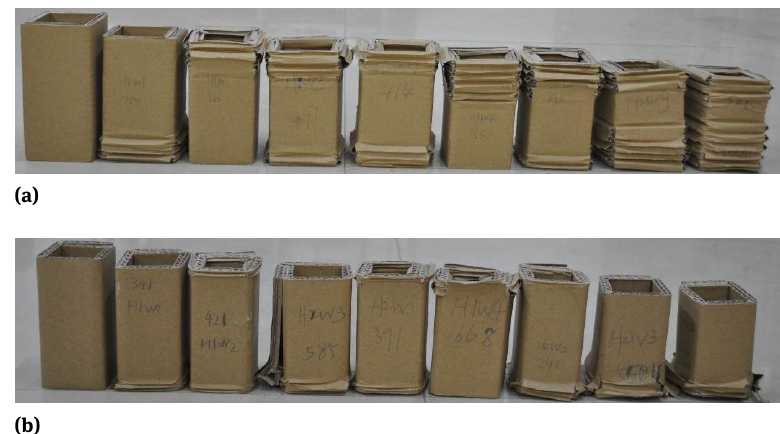
Figure 15: Influence of impact energy on deformation mode: (a) X- and (b) Y-direction square paper corrugation